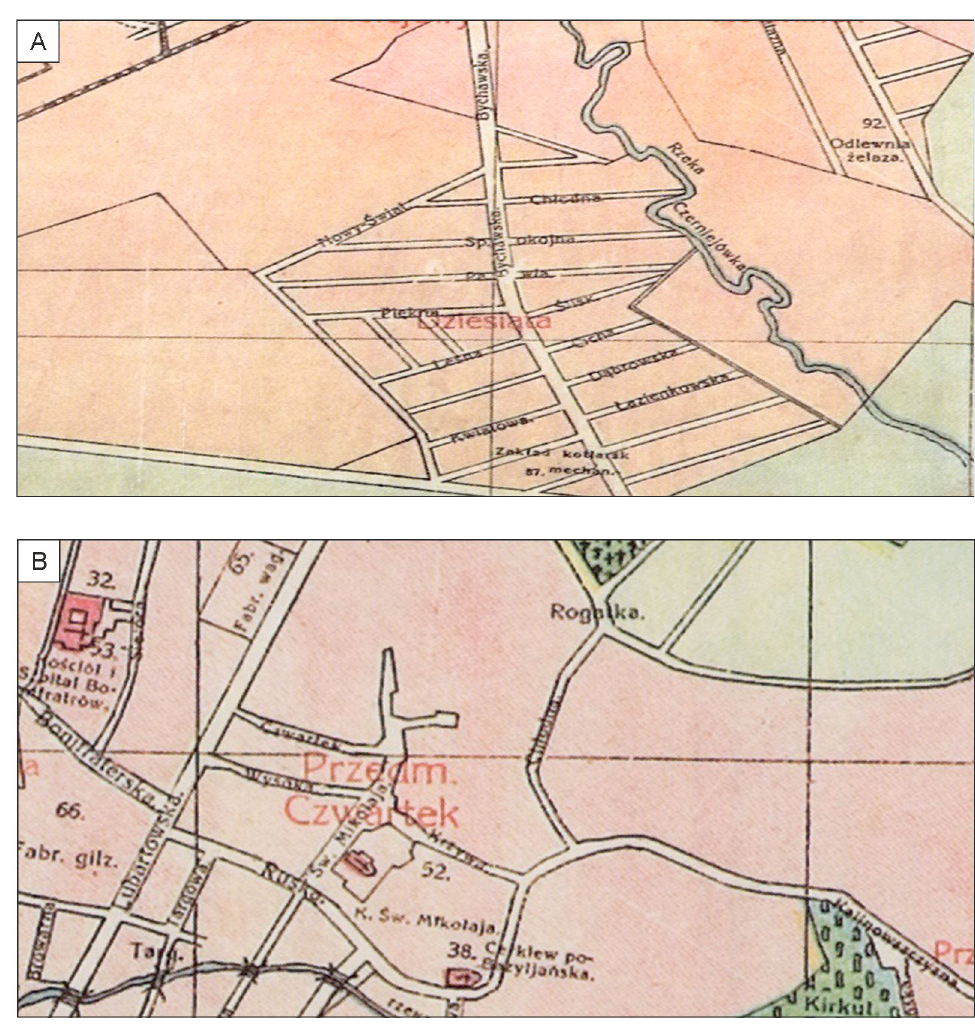
Fig. 5. Chłodna Street on the city map of 1918: A – in Dziesiąta district, B – between the Czwartek Hill and the Kalinowszczyzna Street (source: Lublin , 1: 8400, litogr. and print A. Jerzyński in Lublin,